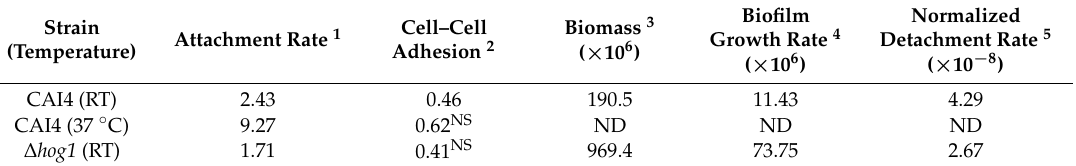
Table 1. Quantification of real-time biofilm formation of Candida albicans under dynamic